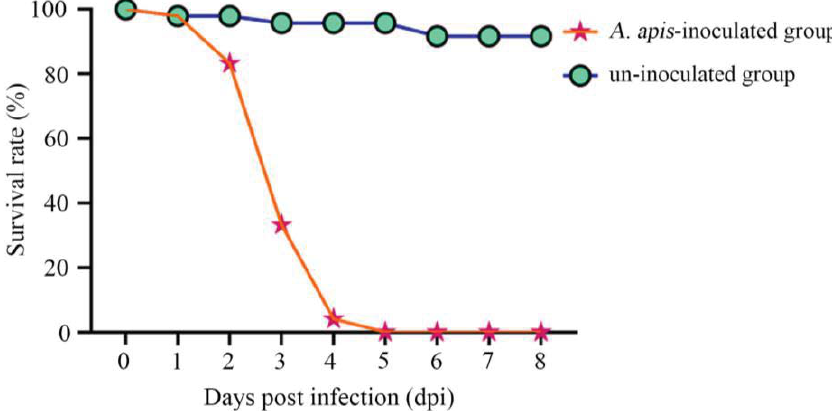
Figure 2. Survival rates of A. apis –infected and uninfected A. cerana larvae.